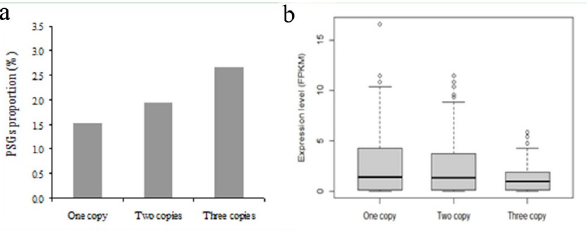
Fig 6. The proportion (a) and expression level (b) of positively selected genes for different type of triplicate genes, i.e, one, two or three copies retained after the triplication event. The band in the box is the median value, and the bottom and top of each box are the first (lower) and third (higher) quartiles. The ends of the whiskers indicate 1.5 interquartile range of first and third quartiles, respectively. Points outside the range are mild